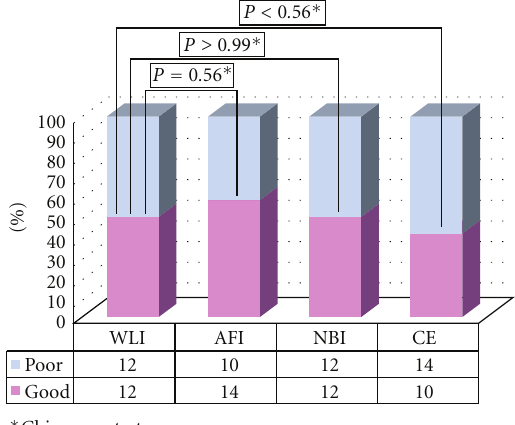
Table 3: Characterization of LST-NG lesions by AFI in group B.